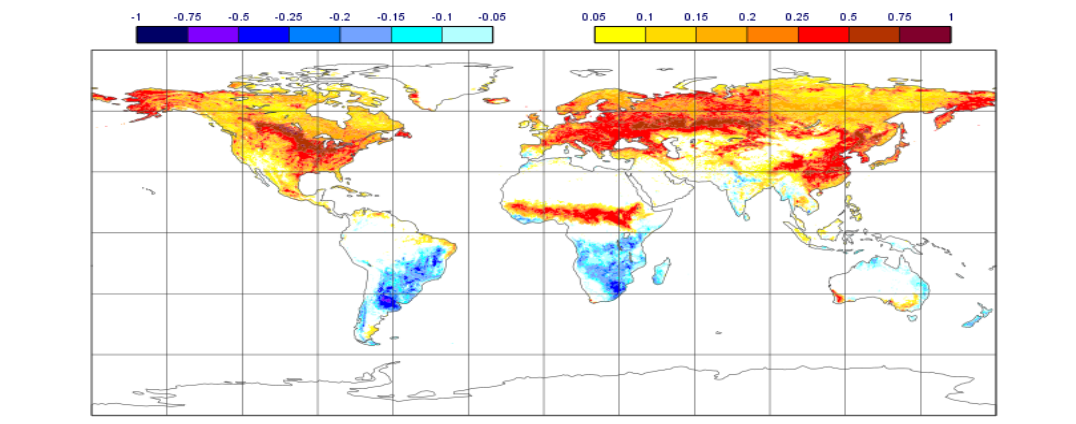
Figure 4. The effect of seasonal varying vegetation cover. ( a ) Bareground fraction difference between the seasonally varying and the static vegetation map for July. ( b ) The seasonal amplitude of low vegetation cover as difference between July and